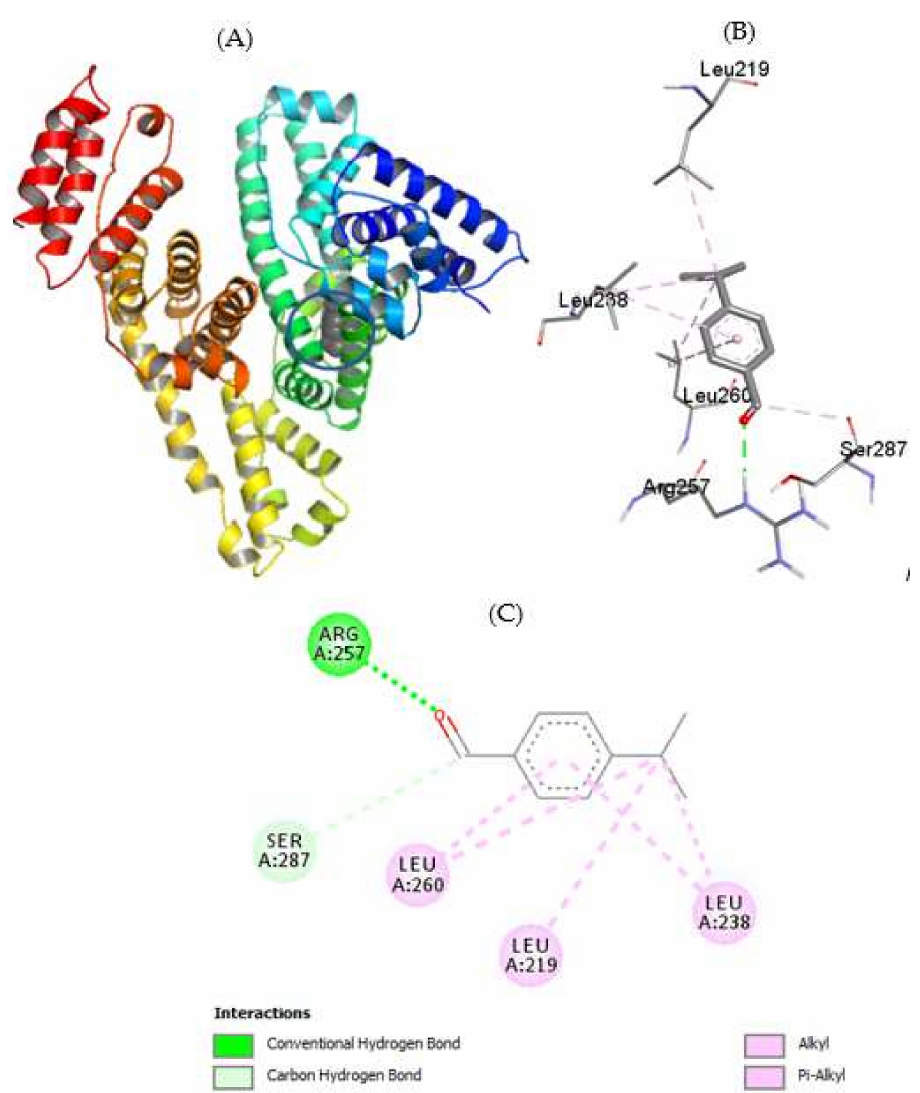
Figure 10. ( A ) Cluster analysis of interaction of cuminaldehyde with HSA ( B ) binding pocket amino acids ( C ) 2-D diagram showing the types of interactions